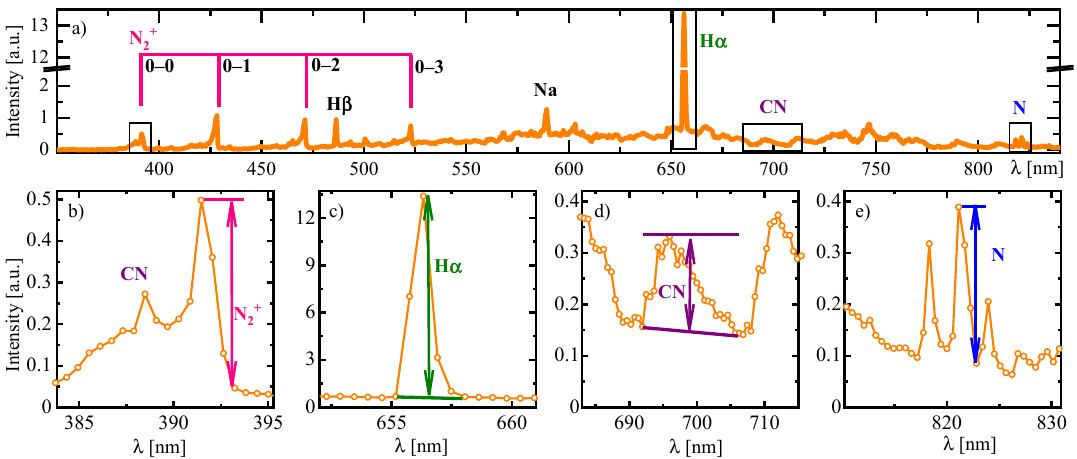
Figure 2. An example of the overview optical emission spectrum recorded by the low-resolution spectrometer with a steel AS at H 2 :N 2 = 1:1, p = 3 mbar, T = 460 °C, Φ Total = 80 slh, Φ CH4 = 4 slh, P AS = 5.8 kW, and P Bias = 0.6 kW ( a ). Selected regions are zoomed in ( b – e ), with the arrows indicating the respective evaluations of peak intensities for N 2+ ( b ), H α ( c ), CN ( d ), and N ( e ).